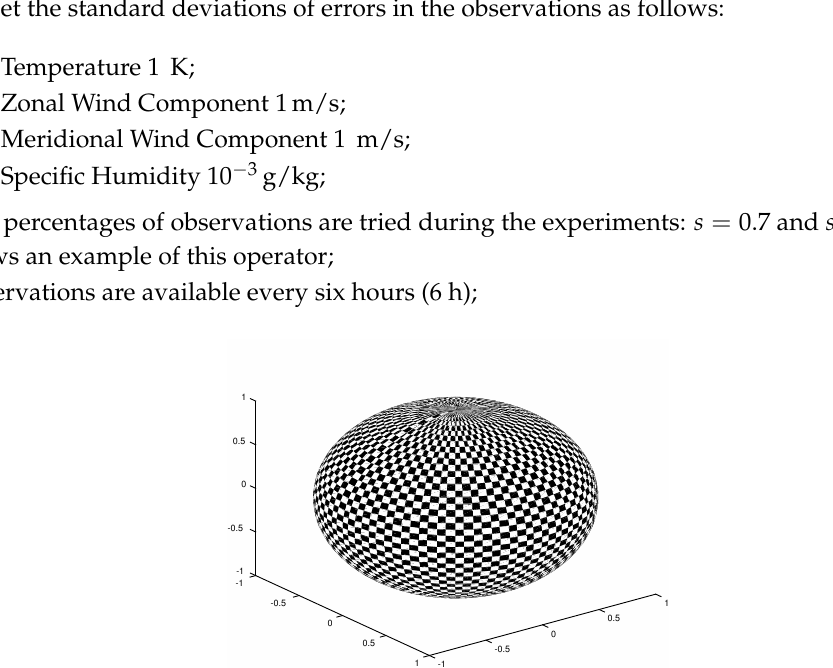
Figure 10. Linear observation operator during assimilation steps. Shaded regions denote observed components (observations) from the model state. The operator is replicated across all numerical